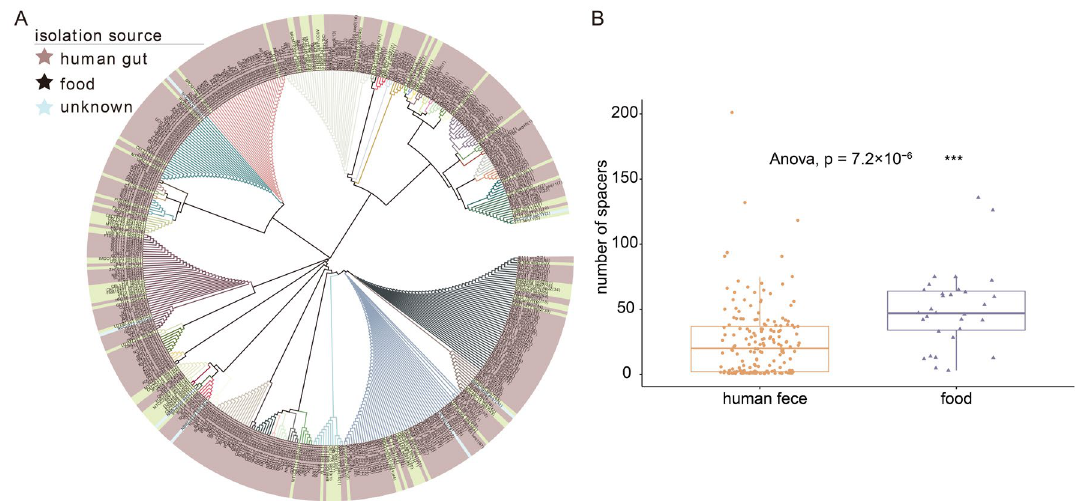
Figure 8. Distribution of the genome − targeting sequences in L. fermentum . ( A ) Phylogenetic analysis of spacer sequences in the genome of L. fermentum strains from human gut and food (Strains in the phylogenetic tree annotated with various leaf background colors correspond to different sources marked by stars in three different colors); ( B ) box plot showed the number of spacers in the genome of L. fermentum strains from two separate sources and * indicate a significant difference in the number of spacers between different group (*** p <